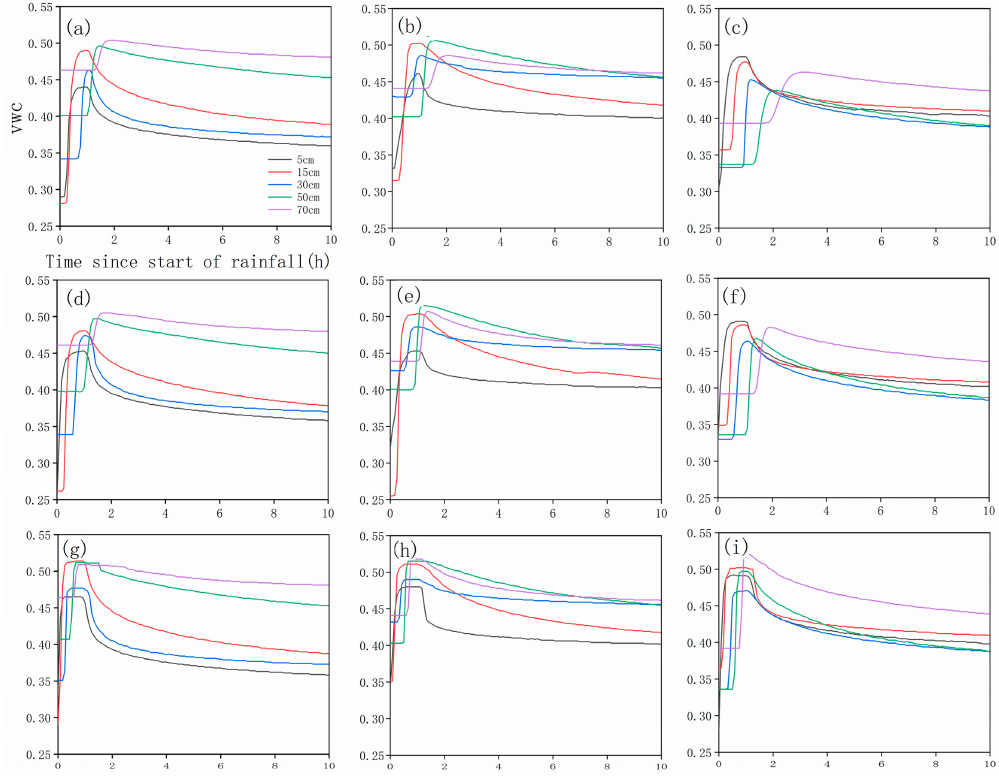
Figure 6. Dynamics of volumetric water content (VWC) for LRD ( a , d , g ), MRD ( b , e , h ) and SRD ( c , f , i ) under 30 mm / h ( a – c ), 60 mm / h ( d – f ), 90 mm / h ( g – i